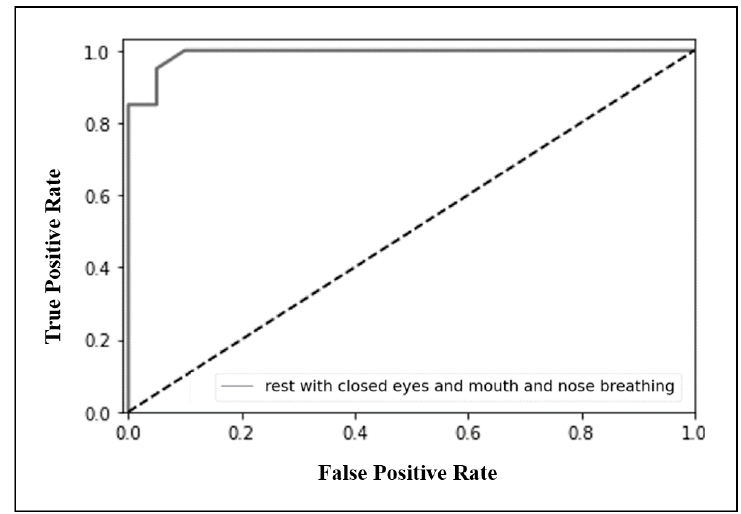
Figure 7. Receiver operating characteristic (ROC) curve and area under the curve (AUC) graph from the condition of rest with closed eyes and mouth and nose breathing, trained with linear discriminant analysis random forest (LDARF) classifier. The AUC of 0.991 confirmed that the LDARF classifier performed well.